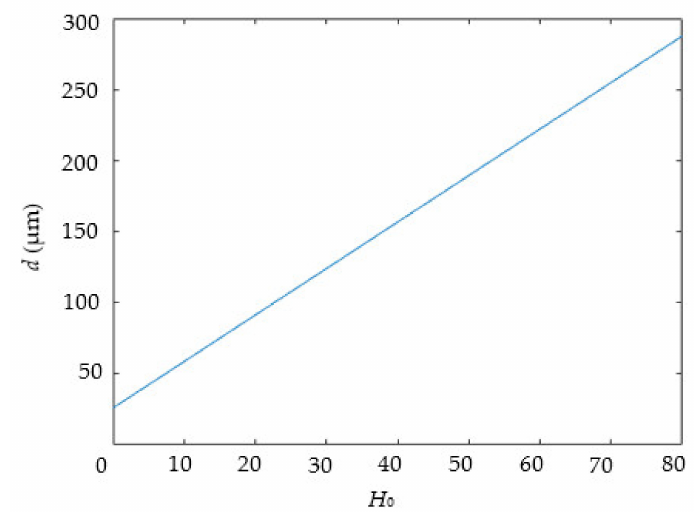
Figure 14. The variation of thickness d in different